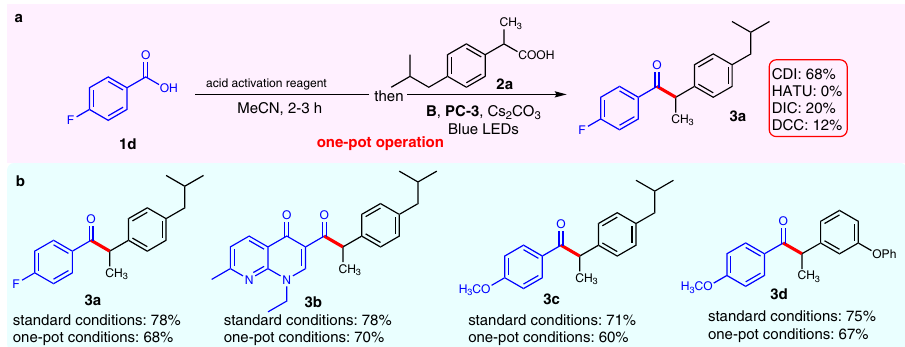
Fig. 2 Development of one-pot operation. a One-pot procedure for coupling of two carboxylic acids. b Comparision between one-pot operation and standard conditions. For synthesis of 3b , DMSO was used as solvent; HATU: 2-(7-Azabenzotriazol-1-yl)- N , N , N ’ , N ’ -tetramethyluroniumhexa fl uorophosphate; DCC: N , N ’ -Dicyclohexylcarbodiimide; DIC: N , N ’